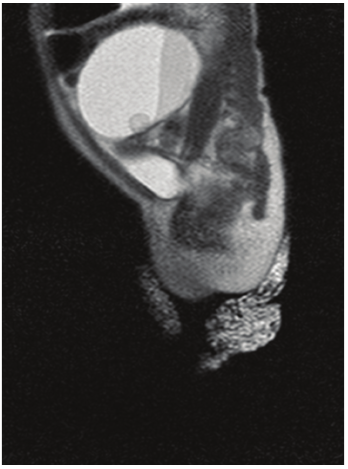
Figure 2: A haste sagittal MBH MRI image demonstrates a 4.5 × 5.6 × 4.5 cm cystic mass with layering hemorrhagic or proteinaceous elements within it. A nodular internal 1.0cm cystic portion against the inner wall of the large mass is also